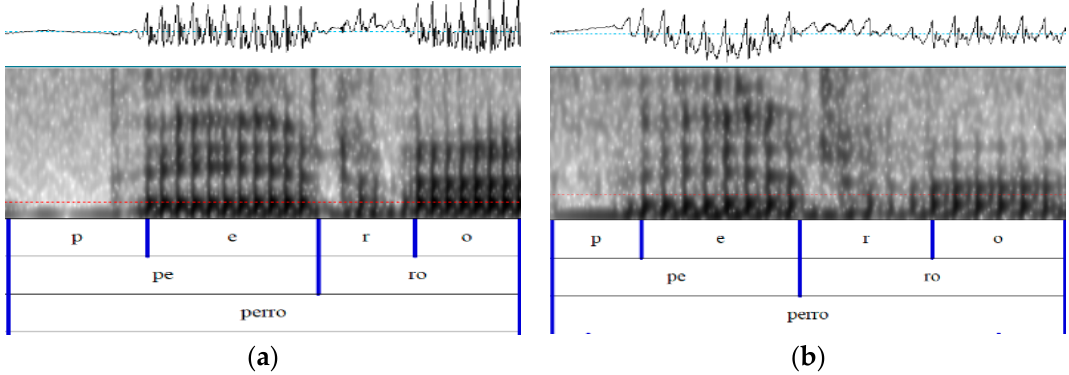
Figure 1. Intervocalic phonemic trill containing ( a ) two true apical occlusions for perro ‘dog’ and ( b ) two approximant apical occlusions for perro ‘dog’.